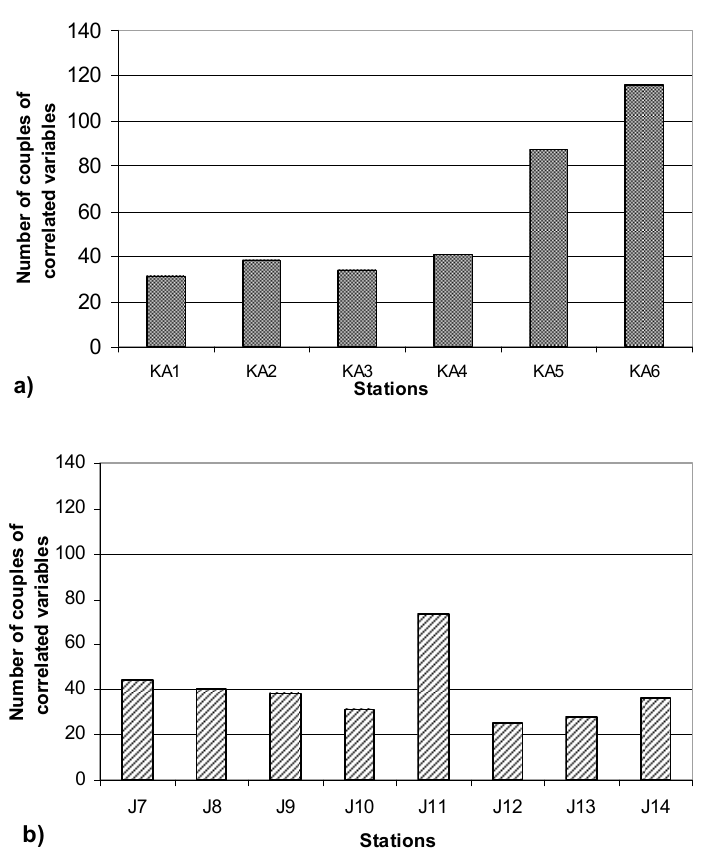
Figure 2. Number of couples of correlated variables with Pearson coefficient >0.5 for each station of the Kadisha Abou Ali ( a ) and El Jaouz ( b ) rivers.